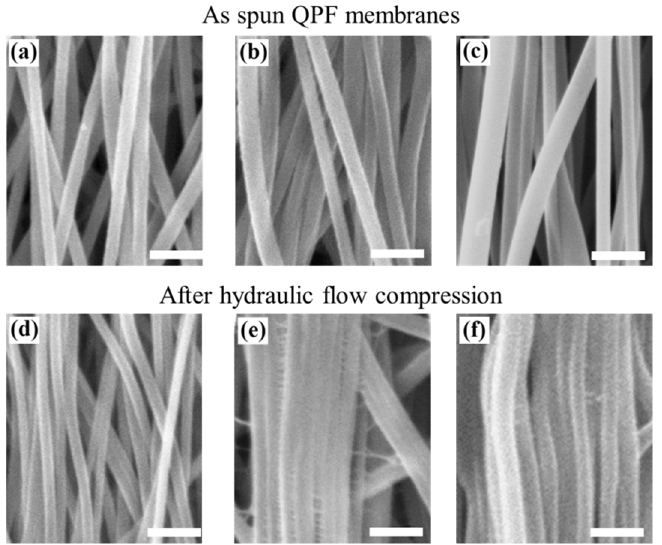
Figure 3. SEM images of electrospun quasi-parallel fibrous (QPF) PAN membranes with various fiber diameters before the hydraulic tests ( a – c ) and after the hydraulic tests ( d – f ) (scale bar: 1 μm).